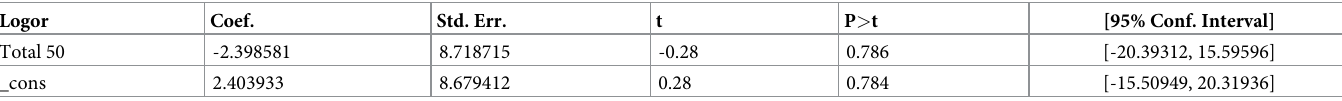
Table 5. Results of STATA regression analysis for AI-assisted diagnosis of lung cancer. Logor Coef. Std.